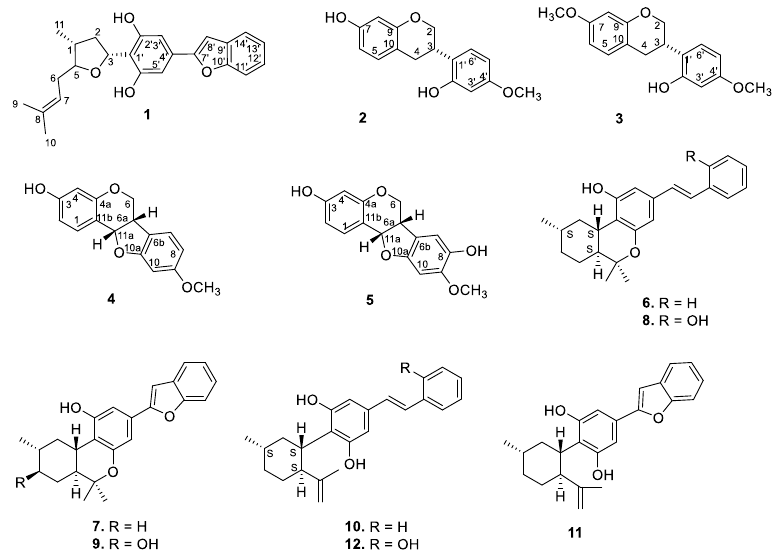
Figure 1. Structures of the isolated compounds.